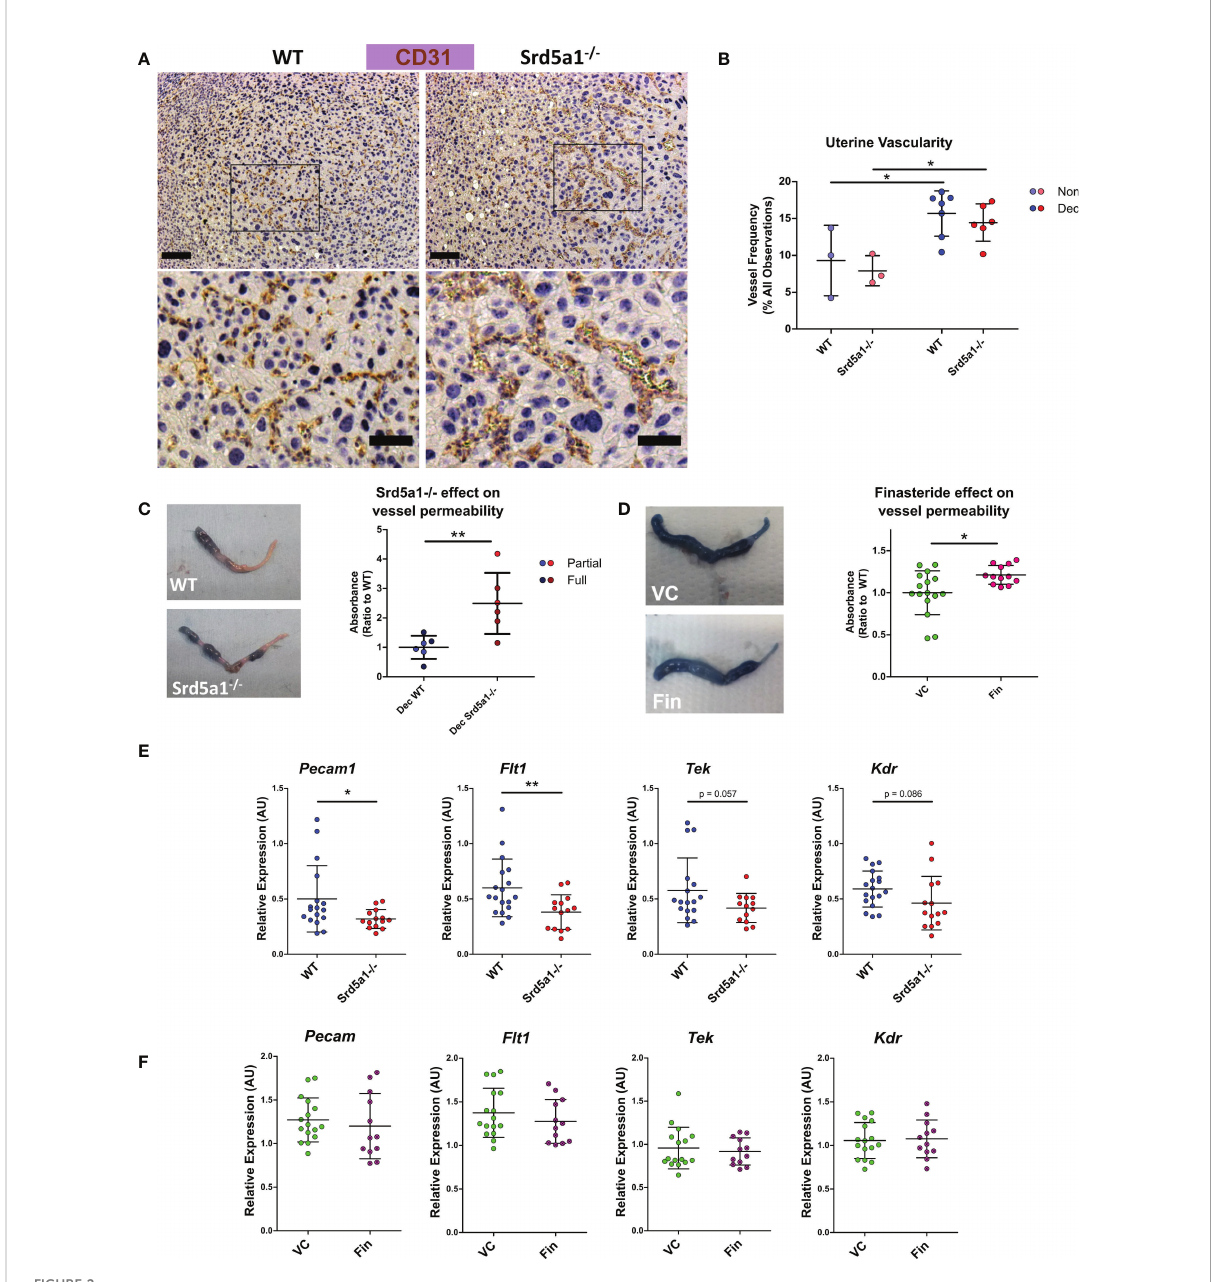
FIGURE 2 Evidence of a vascular phenotype in Srd5a1 -/- mice following induction of decidualization. (A) Representative images of CD31 + cells in WT and Srd5a1 -/- decidua. Zoomed-in views are shown from regions indicated by boxes. Scale bars are 100 m m and 50 m m respectively. (B) Quanti fi cation of vessel density in in WT and Srd5a1 -/- non-decidualized endometrium and decidua. (C, D) Images of decidualized uterine horns following intravenous injection of Evans Blue and respective quanti fi cation of absorbance in uterine tissue extracts in decidualized horns of WT and Srd5a1 -/- (C) or vehicle control (VC) and fi nasteride (Fin) treated mice (D) . (E, F) . Expression of angiogenic genes via qPCR in decidualized tissue (partial and full) from WT and Srd5a1 - /- mice (E) , or VC and Fin mice (F) . Plots in B analyzed by two-way ANOVA with Bonferroni post-hoc tests; (C – F) analyzed by two-tailed t test. **p < 0.01; *p <